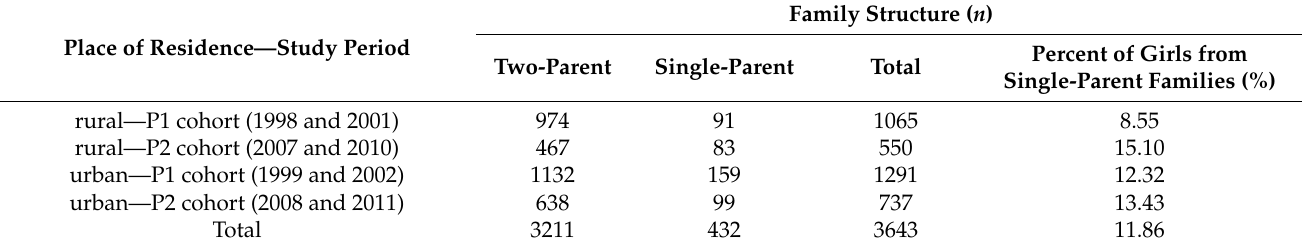
Table 2. The number of rural and urban girls from two-parent or single-parent families for each study